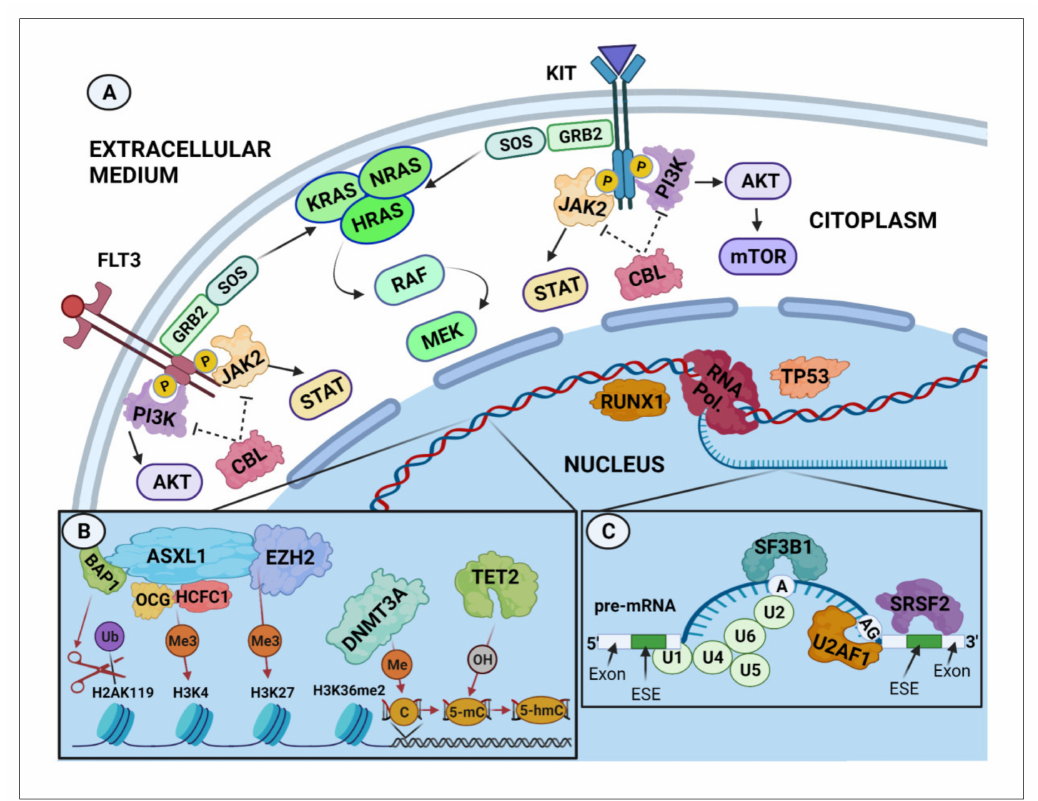
Figure 1. Genes recurrently mutated in systemic mastocytosis categorized by cellular